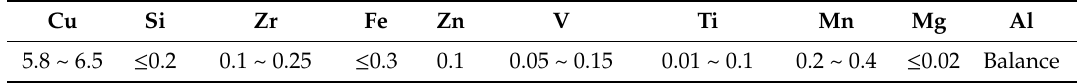
Table 1. Chemical composition of aluminum alloy 2219 (in weight percent).